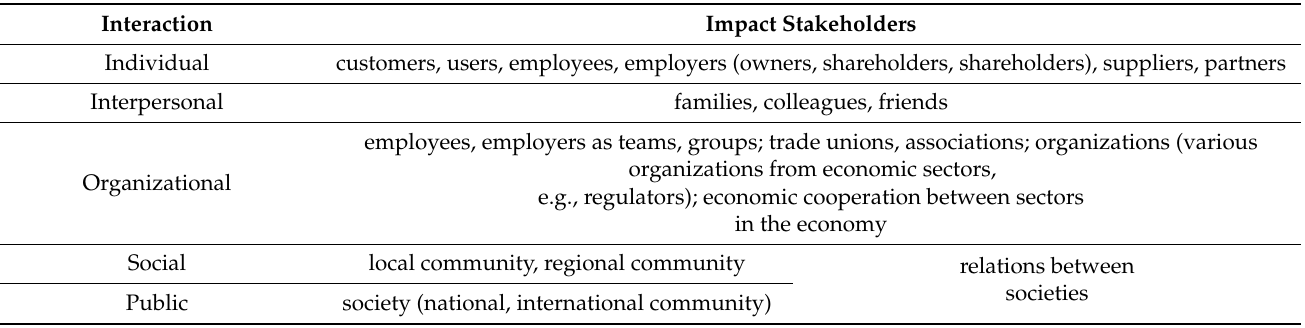
Table 2. Description of the relationship between the segments.